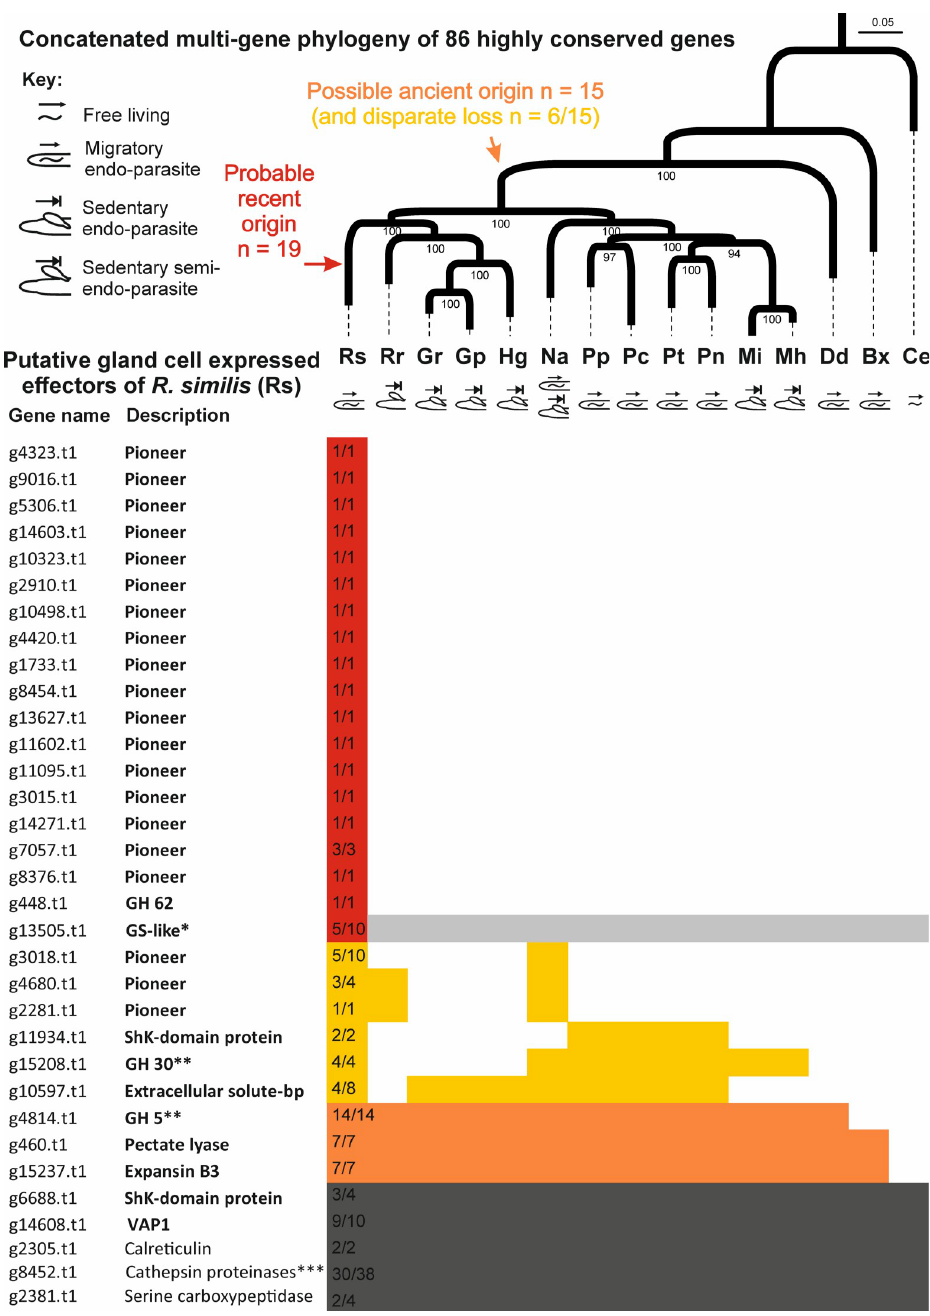
Fig 10. Radopholus similis holds a diverse and emergent repertoire of effectors shaped by diverse evolutionary events. Top panel corresponds to a schematic phylogeny of the phylum Nematoda based on 86 highly conserved genes among plant-parasitic nematodes with distinct lifestyles, and the free-living nematode Caenorhabditis elegans (adapted from [38]). The lower panel indicates the presence/absence of putative homologues through BLAST analyses (e- value < 10 − 5 and bit score > 50) using as query the full set of effectors identified so far for R . similis . The new candidate effectors identified in this study are represented in bold (n = 30). Numbers within the cells of R . similis correspond to the number of genes coding putative secreted proteins in relation to the total number of related genes found in the Rv genome. � Both GH30 and GH5 are represented by the corresponding genes (g15208.t1 and g4814.t1) validated in this study, while cathepsin proteinases are represented by g8452.t1. Legends: Pratylenchus penetrans; Pc: Pratylenchus coffeae ; Pn: Pratylenchus neglectus ; Pt: Pratylenchus thornei ; Mi: Meloidogyne incognita ; Mh: Meloidogyne hapla ; Na: Nacobbus aberrans ; Rs: Radopholus similis ; Rr: Rotylenchulus reniformis ; Hg: Heterodera glycines ;